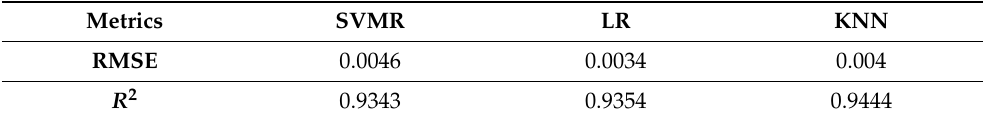
Table 8. Comparison of various